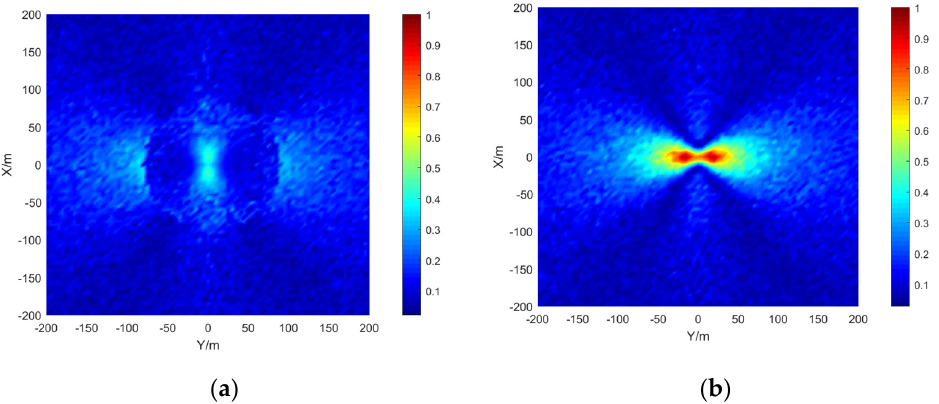
Figure 15. Positioning accuracy of stereo array 1. ( a )combination algorithm ( b )literature 18 algorithm.